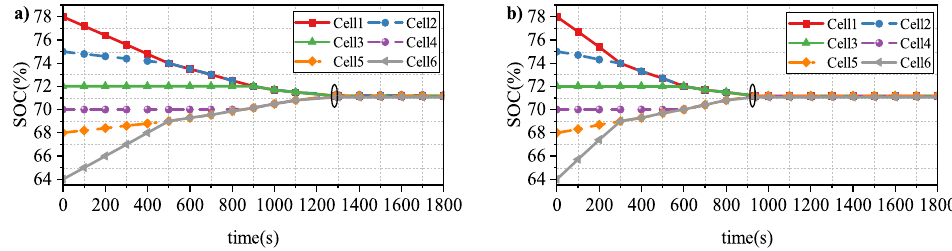
Figure 15. The equalization process of FPID and VFPID in the static state: ( a ) FPID; ( b ) VFPID.